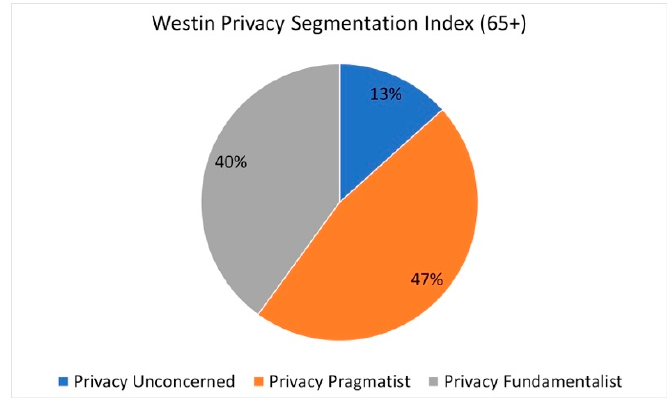
Figure 2. Westin Privacy Segmentation Index Results.